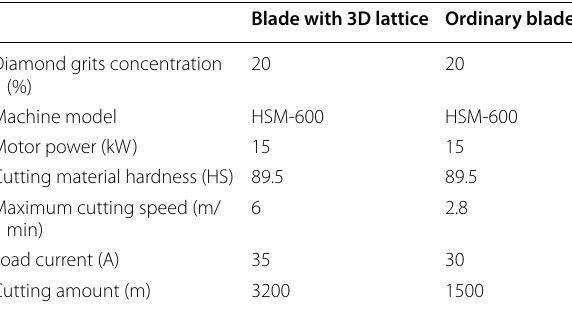
Table 3 Comparison of blade with 3D lattice of diamond grits and ordinary commercial blade